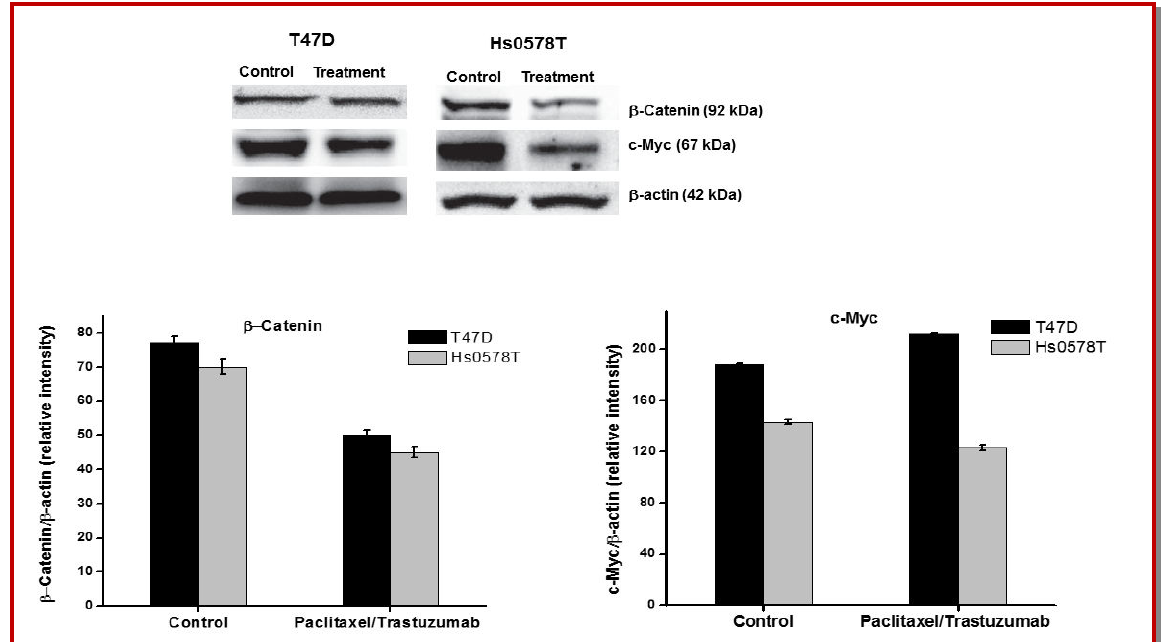
Figure 4: Effect of paclitaxel and trastuzumab in expression of proteins c-Myc and b-catenin in IGF-1 mediated cell